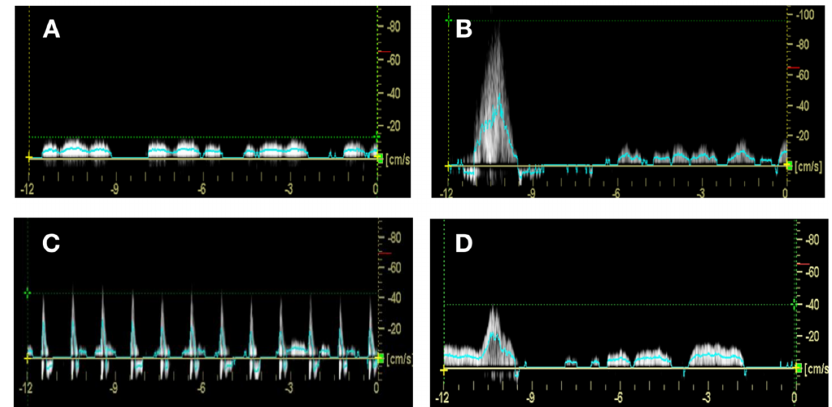
Figure 1. Blood flow waveforms from all interventions. Representative waveform from ( A ) baseline, ( B ) voluntary contraction, ( C ) Geko TM , and ( D ) NUI Galway device. The measurement window for all test conditions included 1 s before stimulation and 11 s of blood flow post stimulation onset. Peak velocity was measured off the crossing point of the blood flow waveform and the horizontal dashed line in green. The TAMEAN is plotted as a solid blue line over the course of the measurement. Statistical analysis: Statistical analysis was carried out using a one-way ANOVA (Tukey multiple comparison test). This was performed using GraphPad Prism. The significance was taken at p < 0.05.